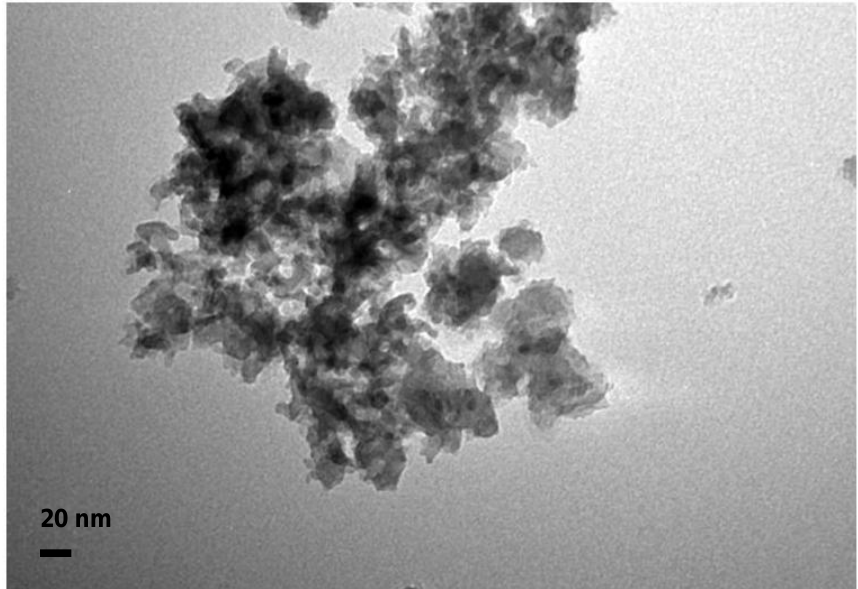
Figure A8. Microphotography of Ru/Al 2 O 3 -Ca(10 wt%) catalyst.